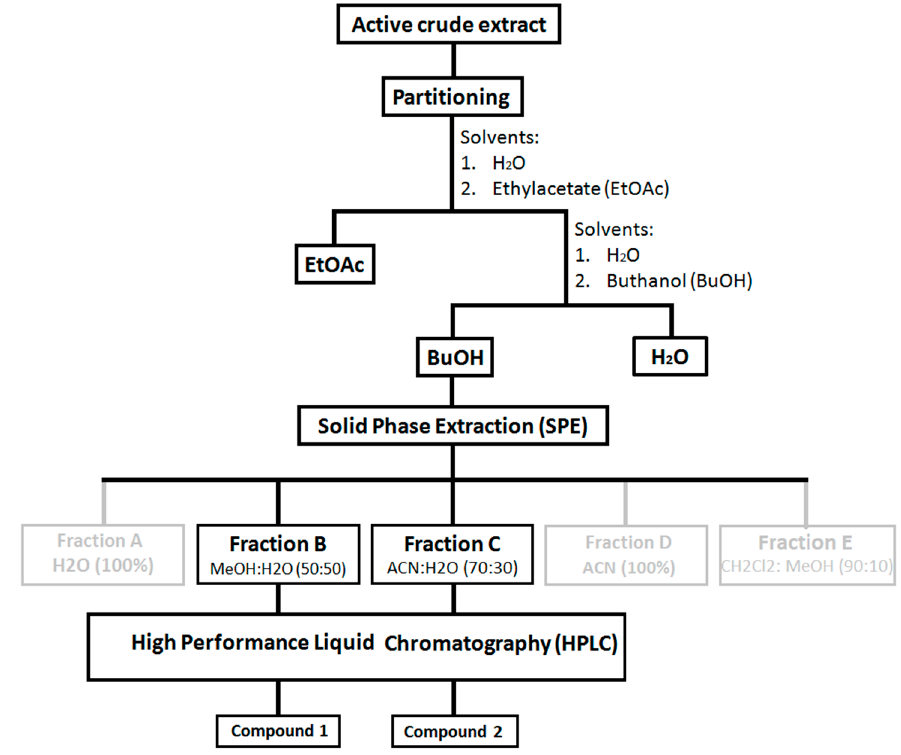
Figure 12. Workflow applied for isolating the bioactive saponin compounds from three most active sea cucumbers, B. argus , H. fuscopunctata and S. chloronotus . Compounds 1 (i.e., bivittoside D ) and 2 (i.e., bivittoside C ) were both isolated from “Fraction B” and “Fraction C” of B. argus .